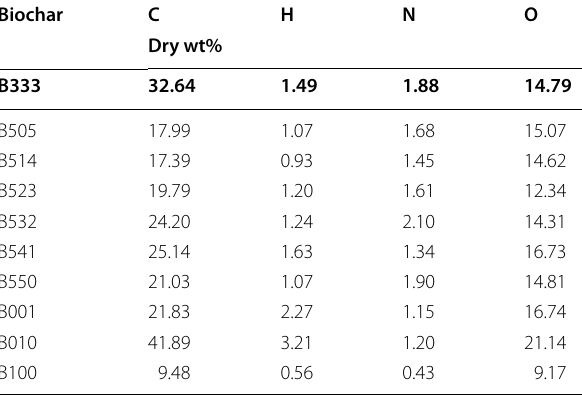
Table 2 Elemental analyses (in dry wt% of biochar prepared through lab-scale pyrolysis of BM and MM at 500 °C